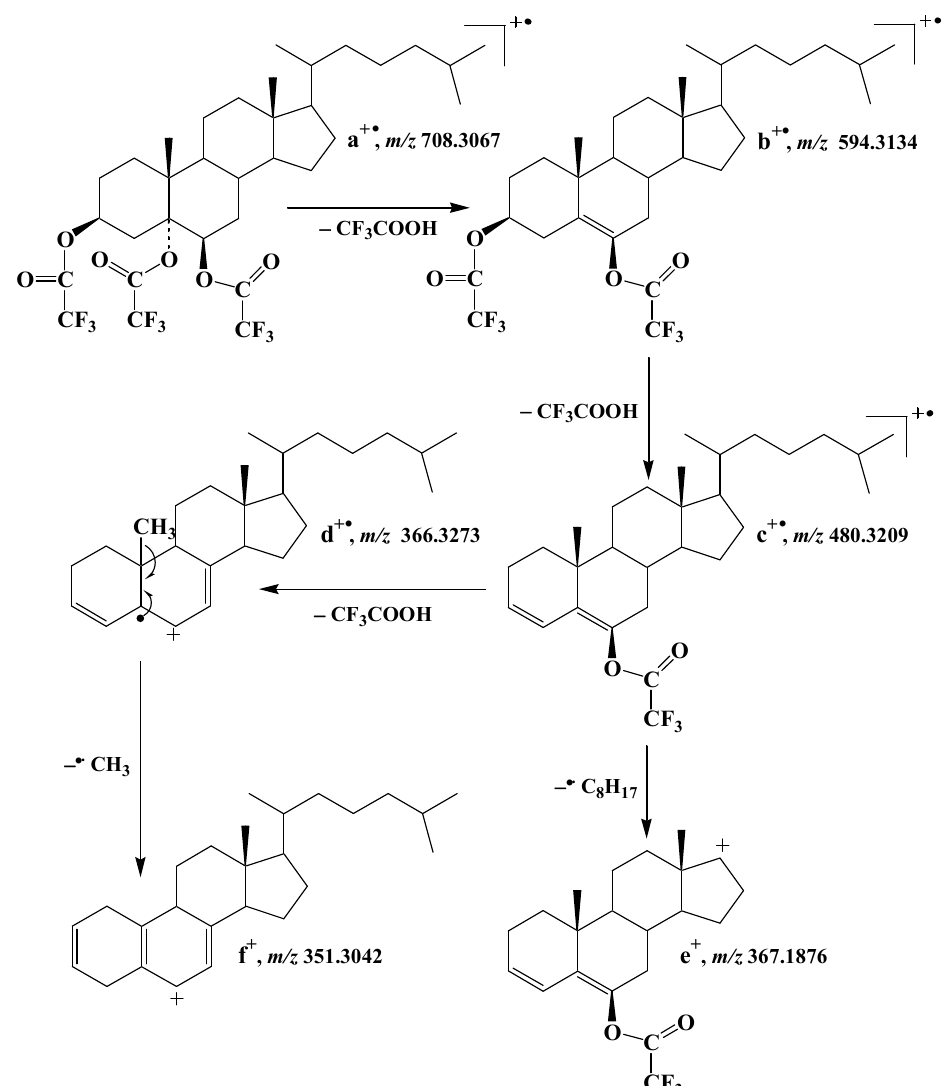
Figure 3. Proposed fragmentation of cholesta-3 β ,5 α ,6 β -triol trifluoroacetate derivative. Note that